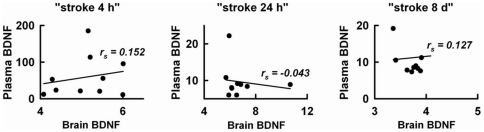
Scatter plot between individual levels of BDNF in plasma (ng/mL) and brains (mg/g) that were simultaneously measured 4 h, 24 h, and 8 d after embolization in the “stroke 4 h”, “stroke 24 h”, and “stroke 8 d” groups (10 rats per group), respectively, rs = Spearman's rank correlation coefficient.